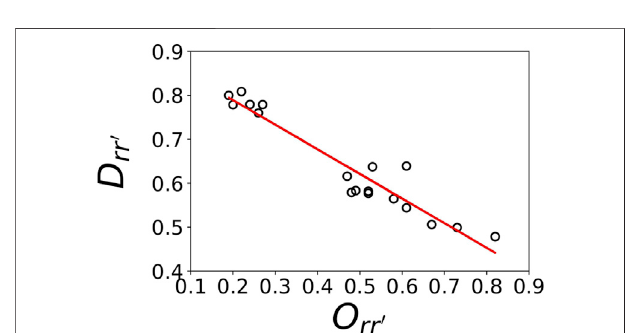
FIGURE12 | Dissimilarity index D asafunction ofthe Overlap coef fi cient O . The red line least-squares shows a strong correlation between the two indices with an angular coef fi cient m (cid:1) − 0.57 ± 0.1 and the Pearson correlation coef fi cient, ρ (cid:1) −